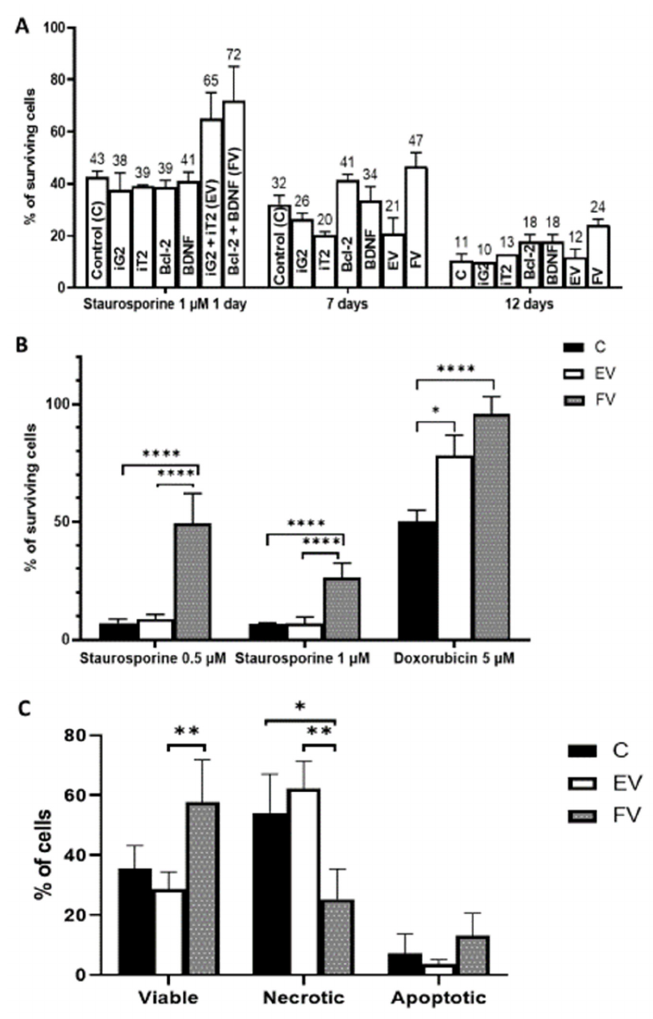
results showed that the duration of the culture was lengthened in order to strengthen the positive cytoprotective effect of the Bcl-2 and BDNF overproduced proteins. After the short-term overexpression (Figure 4A Left) was compared with the long-term overproduction (Figure 4A Right and Figure 4B) of the investigated proteins: Bcl-2 and BDNF (FV), we could state that the long-term overexpression had a cytoprotective effect on the MSC under staurosporine conditions. A full post hoc analysis is presented in Table 1.